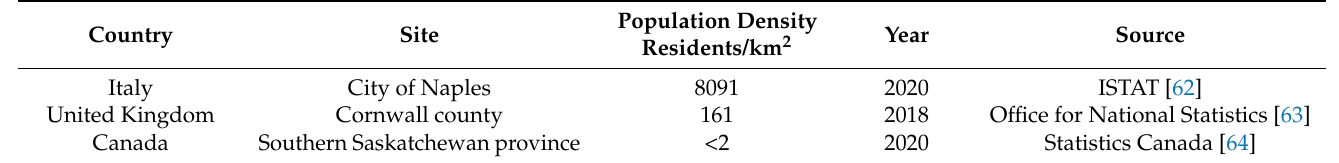
Table 3. Population density in the regions of the three geothermal projects reviewed.